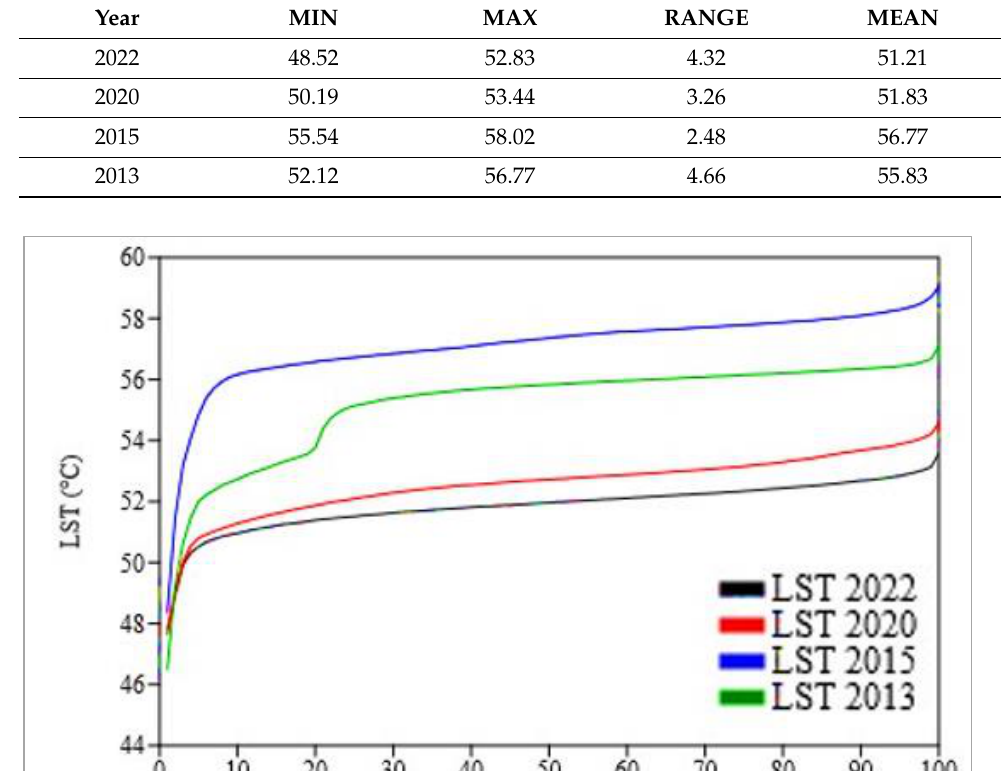
Table 4. Statistics (masked by the built green town subsurface) of land surface temperature (LST) changes according to the studied years.